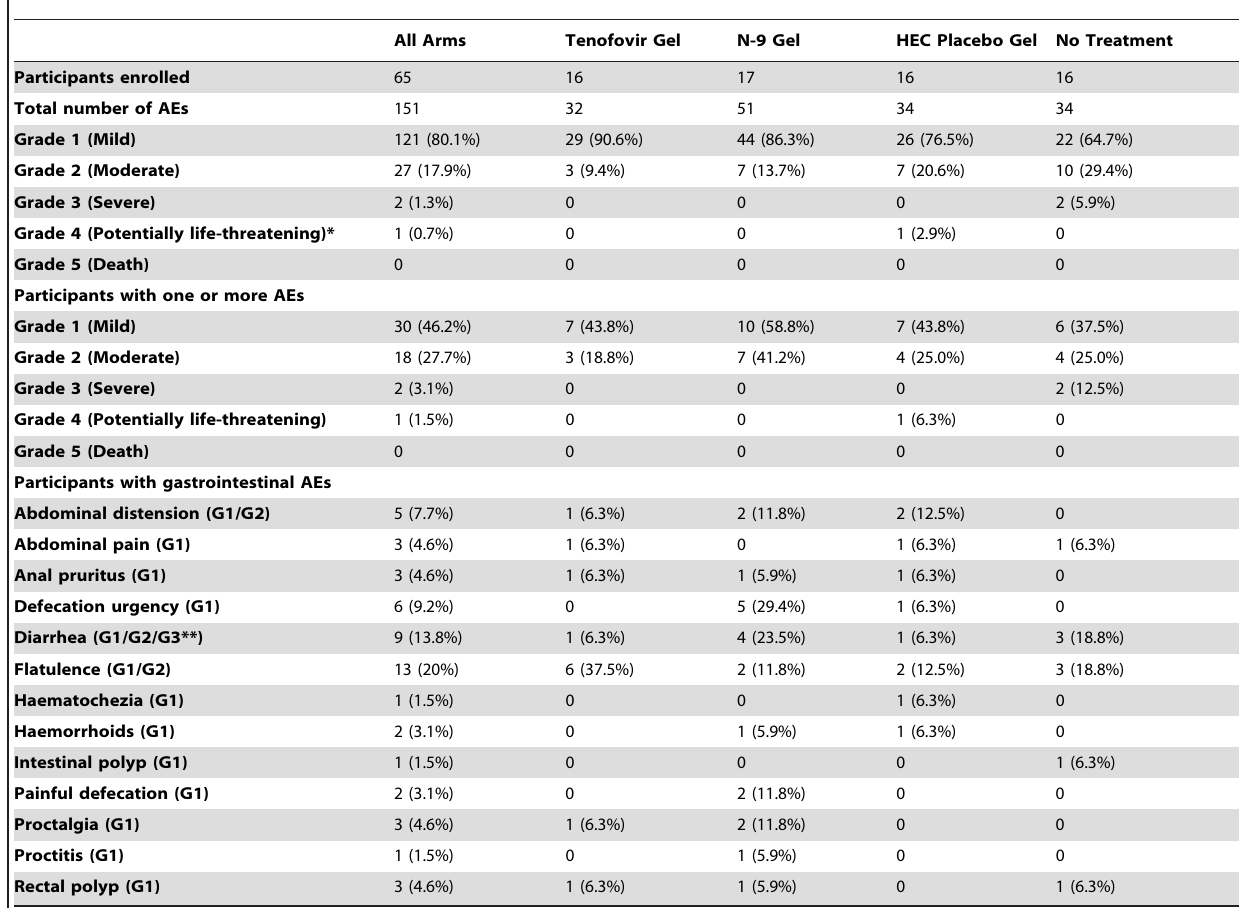
Table 2. Participants reporting adverse events by study